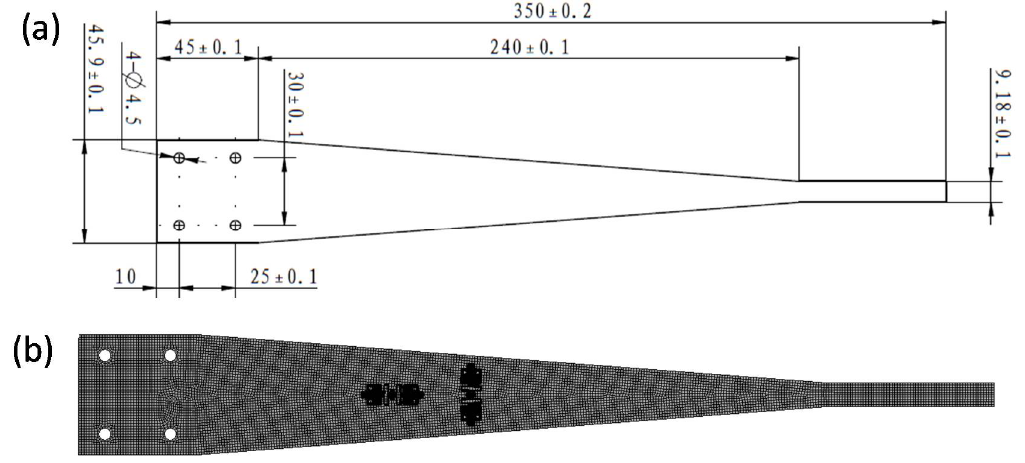
Figure 4. The simulation model of the sensor and the cantilever beam: ( a ) modeling dimensions of the cantilever beam; ( b ) the position of the FBG sensors on the cantilever beam. ε v is defined as the width direction strain of the beam surface, ε as the strain in the length direction of the beam surface, ε fv as the strain of the FBG sensor in the width direction of the beam and ε f as the FBG sensor strain on the length direction of the